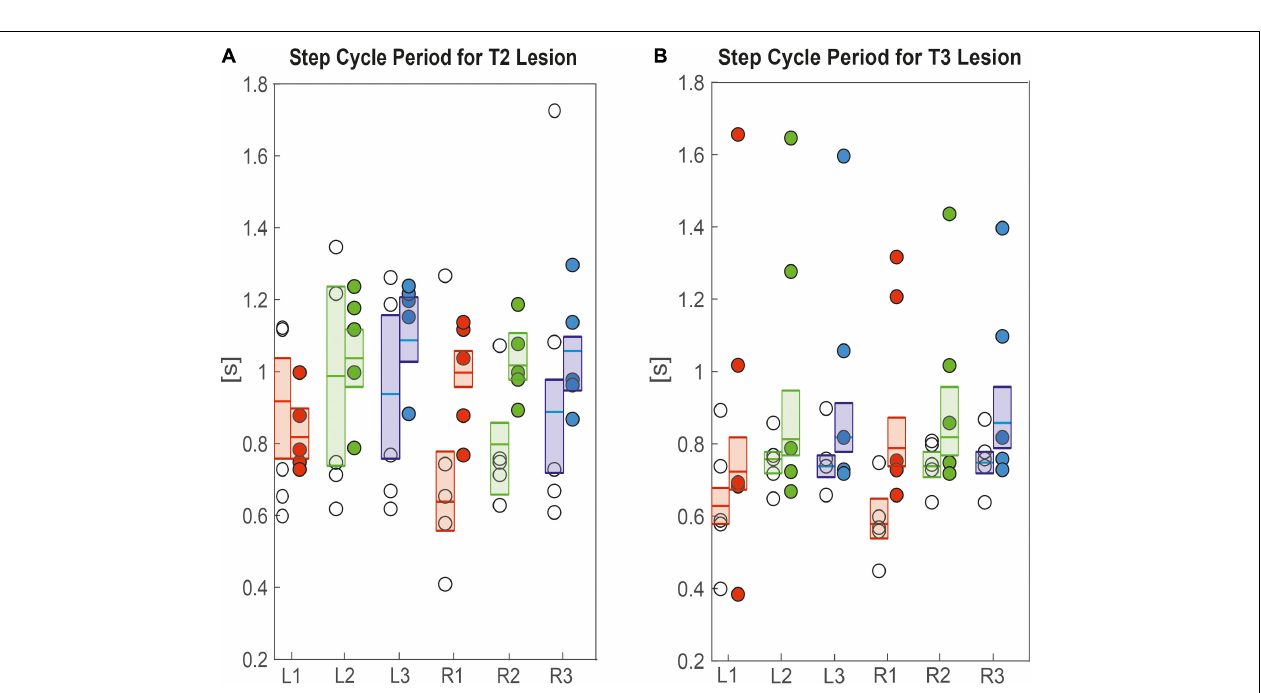
FIGURE 5 | Effects on step cycle period. (A) Pro-to-mesothorax connective; (B) meso-to-metathorax connective. Symbols show the median step cycle period per animal after lesion (filled circles) or a sham operation (open circles). Boxes comprise all trials of the cohort and show the median and the bootstrapped 95%